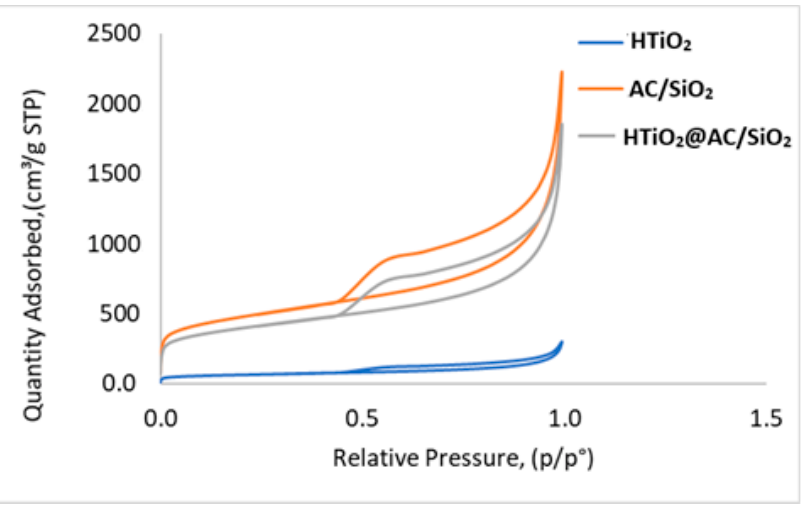
Figure 4. Adsorption-desorption isotherm of AC/SiO 2 , HTiO 2 , and HTiO 2 @AC/SiO 2 composites.